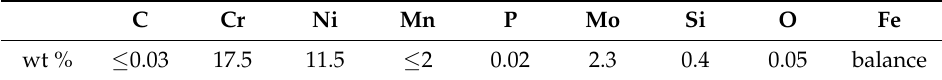
Table 1. Chemical composition (wt %) of 316L stainless steel [1].